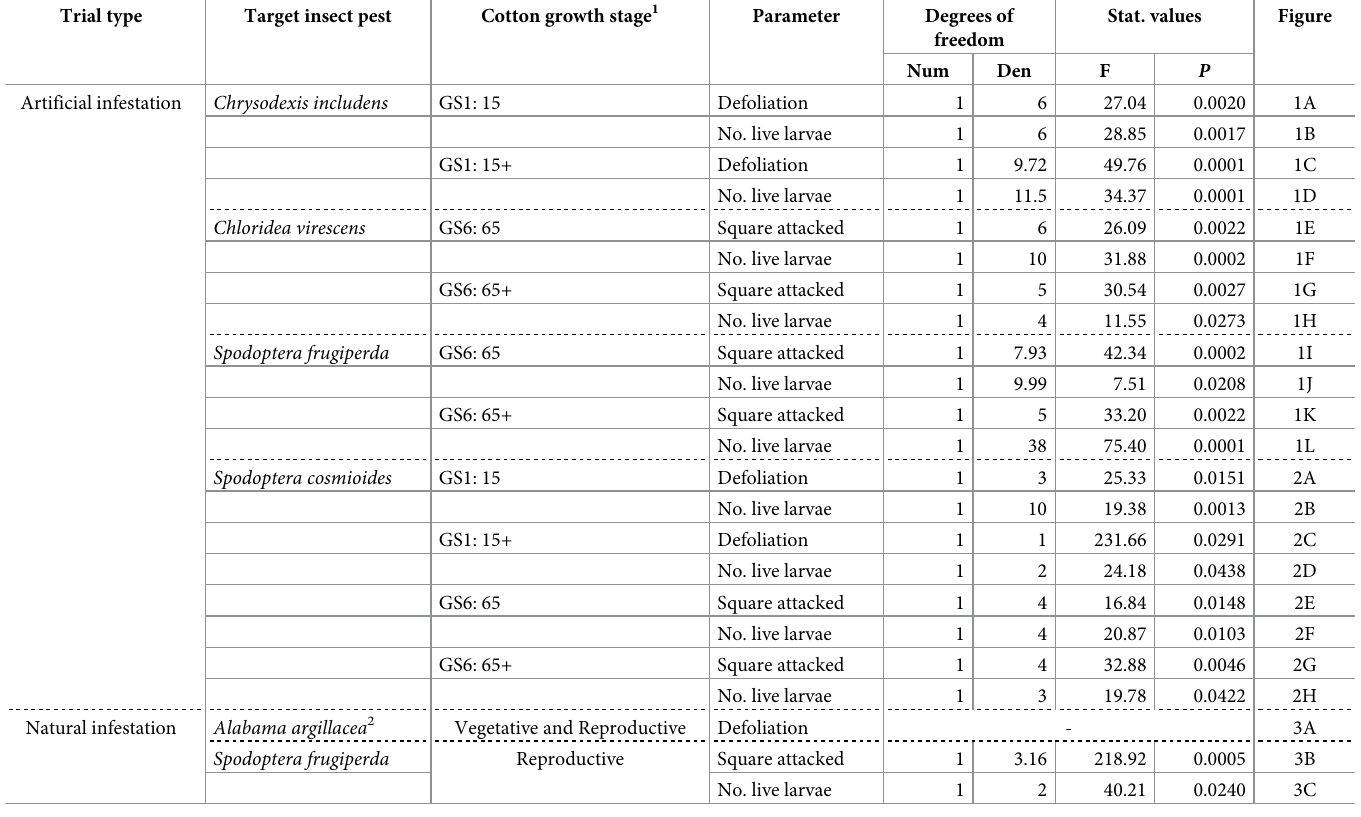
Table 2. Results of linear mixed model analyses using an F -test ( α = 0.05) to compare efficacy of Bt cotton technology with events DAS-21023-5 × DAS-24236- 5 × SYN-IR102-7 and non- Bt cotton against lepidopteran pests at different cotton growth stages. Trial